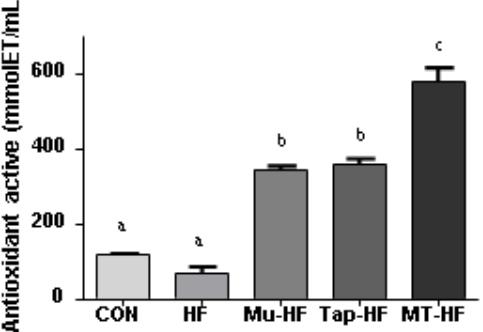
Figure 4. Antioxidant potential for ORAC assay of rat liver tissue cells with high-fat diet supple- mented with murici and tapereba fruit-based beverages. CON = control group; HF = high-fat group; Mu-HF = murici beverage group; Tap-HF = tapereba beverage group; MT-HF = murici and tapereba blend group. All values are expressed as mean ± SD. n = 4 to 10 per group. Means with different letters are significantly different ( p < 0.05, Tukey’s test). Table 4. Antioxidant potential of rats’ serum with high-fat diet supplemented with fruit-based bev- erages murici and tapereba evaluated by different assays.